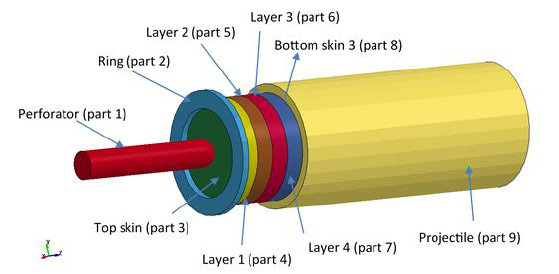
Fig. 1. Numerical model for the perforation of a graded core sandwich panel, testing configuration.